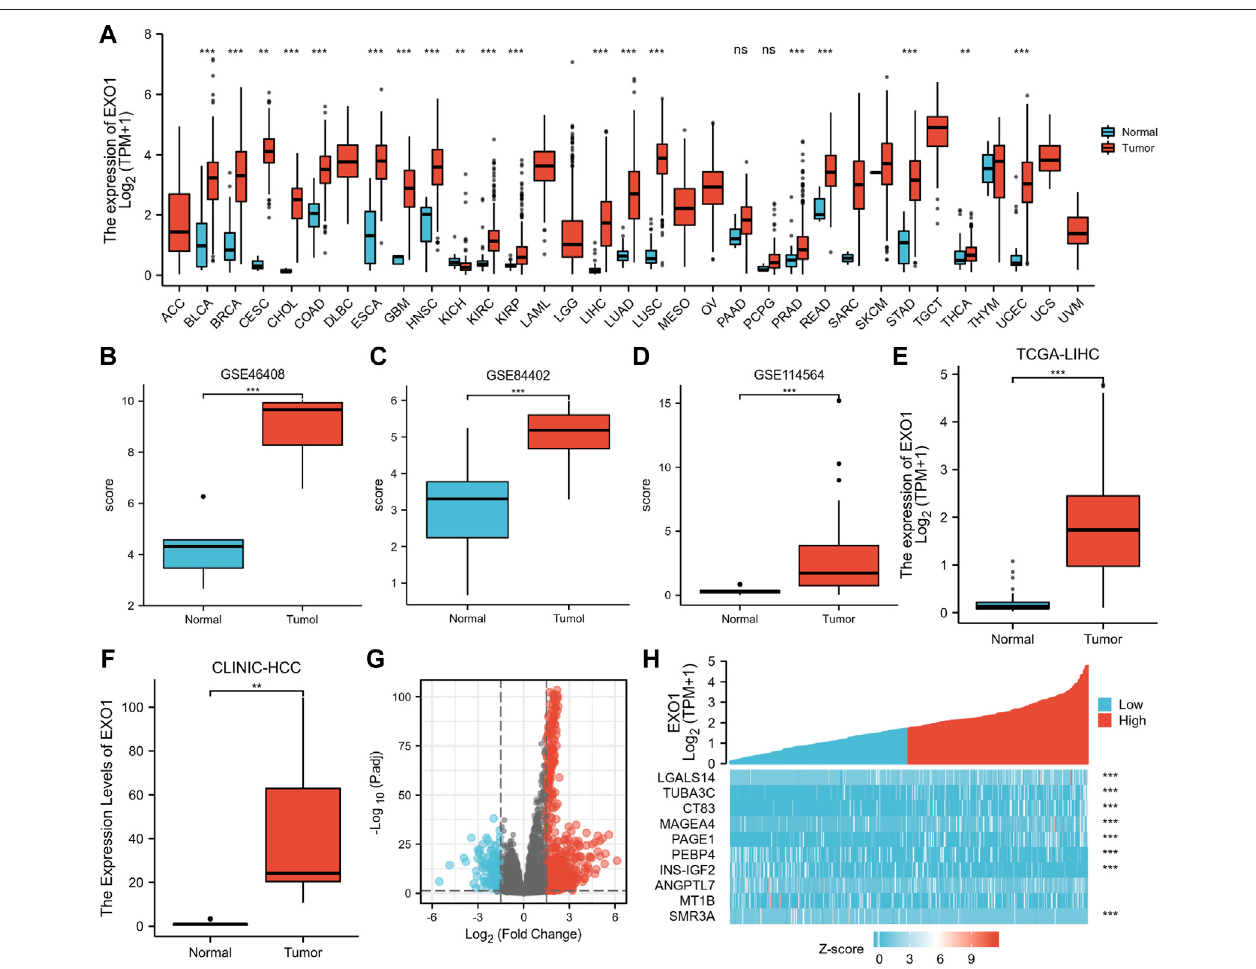
FIGURE 1 | EXO1 expression signi fi cantly up-regulated in multiple cancers including HCC. (A) TCGA database analysis shows the EXO1 expression levels in 33 typesofcancertissuesandtheircorrespondingadjacentnormaltissues.ns, p ≥ 0.05;** p < 0.01;***, p < 0.001. (B,C) EXO1expressionlevelsweresigni fi cantlyhigherin the HCC tissues compared to the adjacent peritumoral liver tissues in the (B) GSE46408 and (C) GSE84402. (D) EXO1 expression levels were signi fi cantly higher in the serum of HCC patients compared to the healthy subjectsin the GSE114564 dataset (p < 0.001). (E,F) EXO1 expression levels were signi fi cantlyhigher in the HCC tissues compared to the adjacent peritumoral liver tissues (E) TCGA-LIHC datasets and (F) clinical HCC samples. (G,H) According to the median EXO1 level, 424 HCC patientsfromtheTCGA – LIHCprojectweredividedintohigh-andlow-EXO1expressiongroups. (G) Thevolcanoplotsand (H) theheatmapsshowtheexpressionlevels of speci fi c mRNAs in the HCC patients with high- and low-EXO1 expression ( n = 422) from the TCGA-LIHC project.